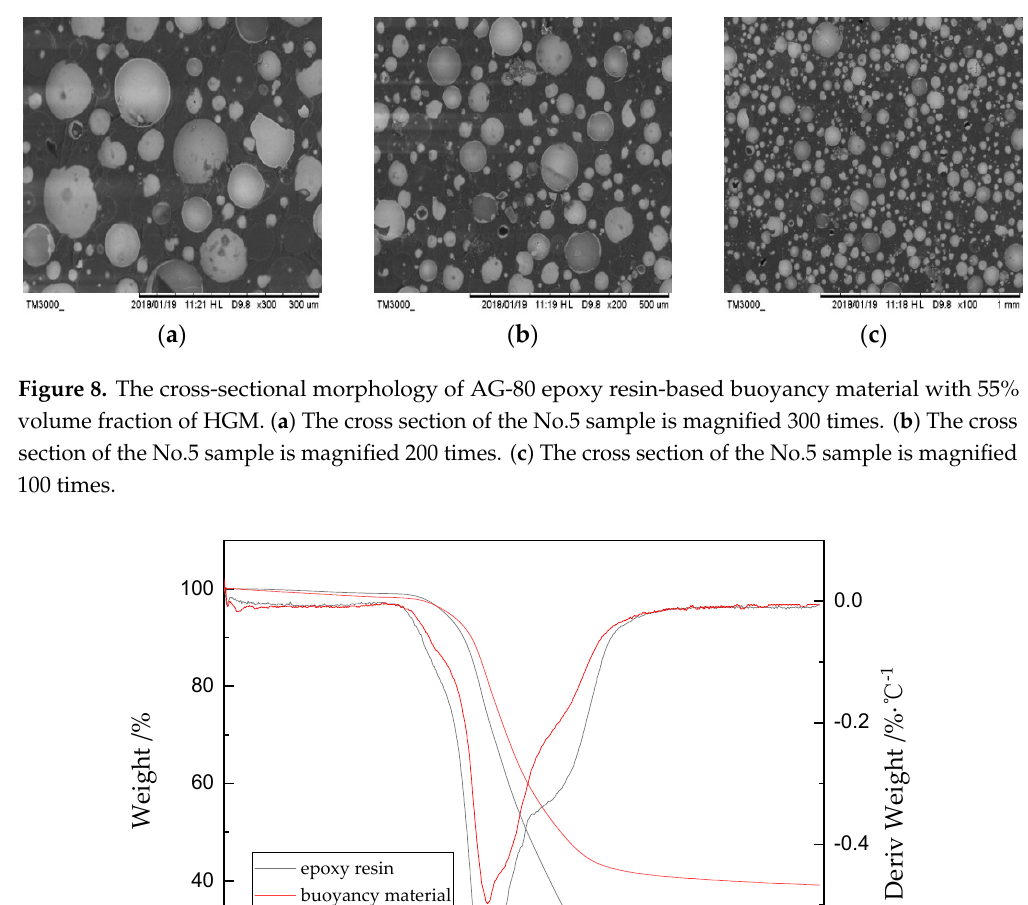
Figure 8. The cross-sectional morphology of AG-80 epoxy resin-based buoyancy material with 55% volume fraction of HGM. ( a ) The cross section of the No.5 sample is magnified 300 times. ( b ) The cross section of the No.5 sample is magnified 200 times. ( c ) The cross section of the No.5 sample is magnified 100 times.